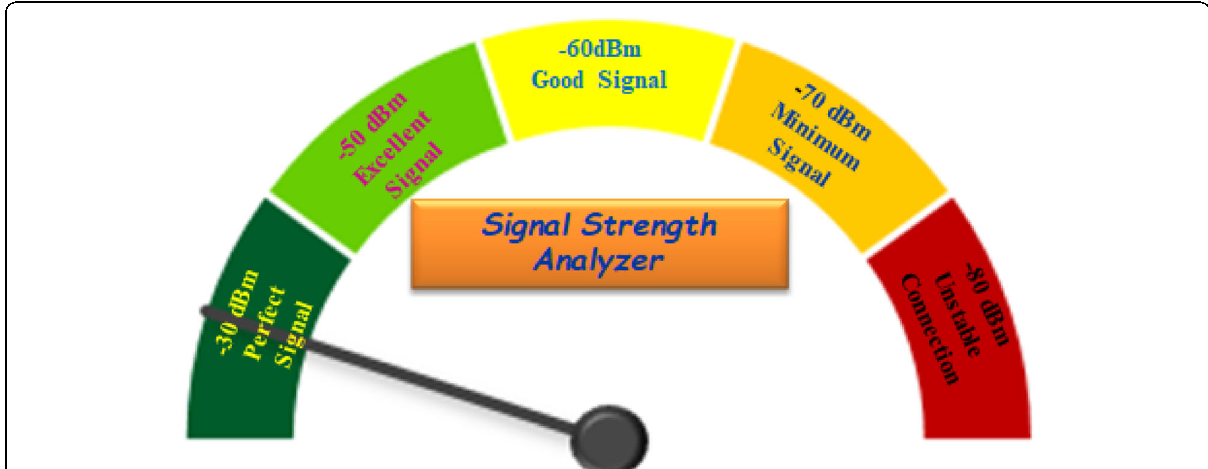
Fig. 6 Context-aware signal strength analyzer. The figure illustration the coordinates with decision module, and the network monitors nodes, Wi- Fi connection states and their